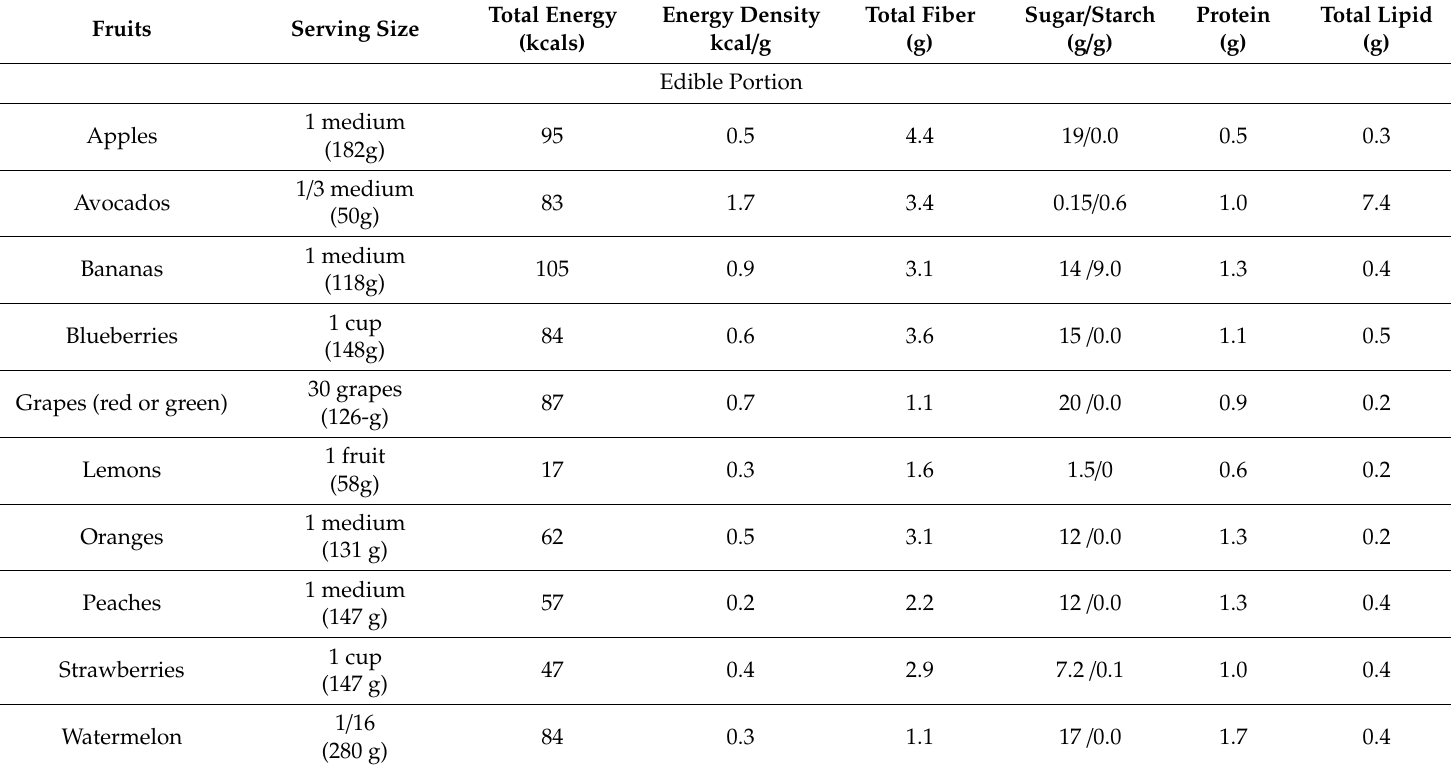
Table A2. Top ten most consumed whole fruits in the US and their nutrition components per serving, which are generally associated with weight management [84].